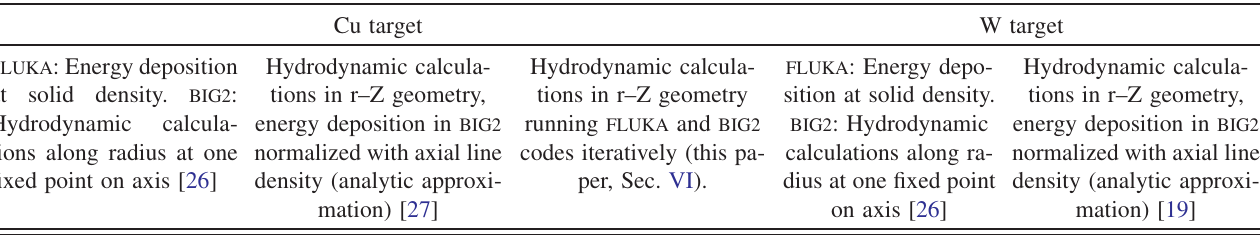
TABLE II. Overview of SPS calculations.